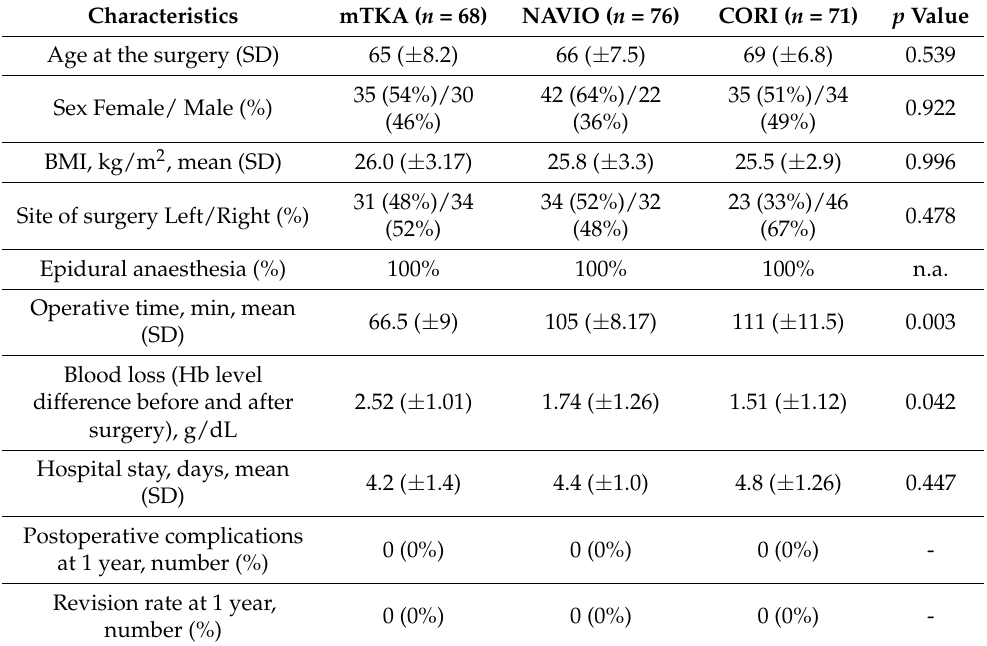
Table 1. Characteristics of patients who underwent NAVIO CORI robotic-assisted TKA at baseline and intraoperatively.